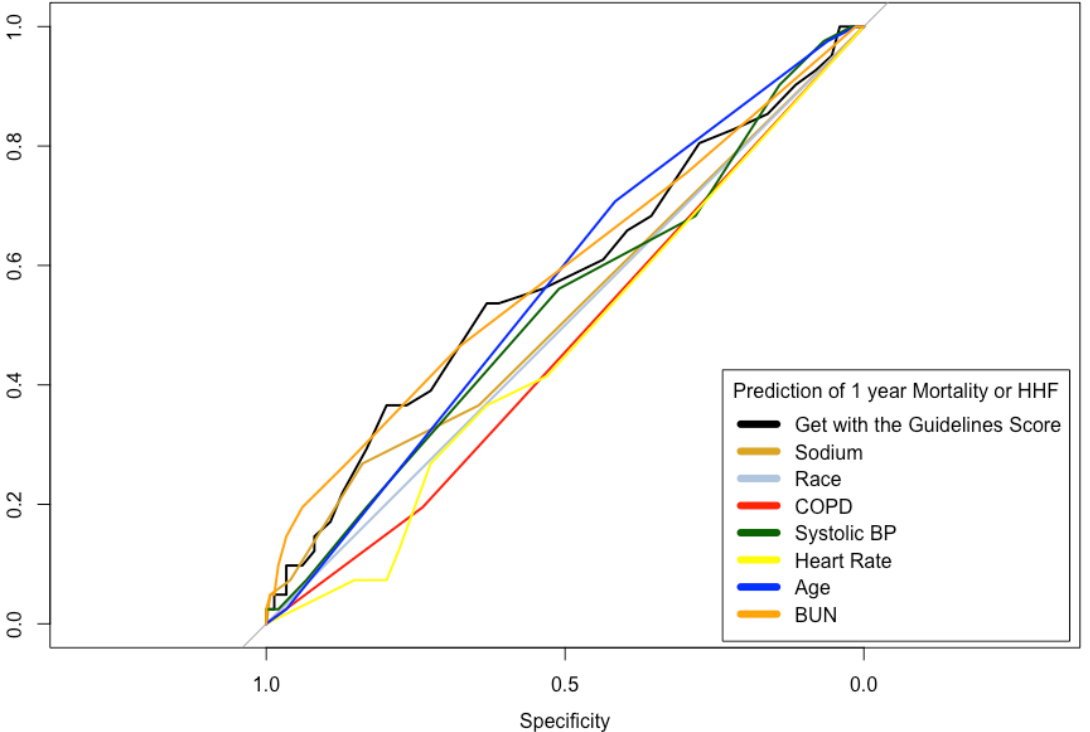
Figure 2. Prediction of composite endpoint (mortality + HHF). ROC analysis for prediction of composite endpoint of mortality and hospitalization for heart failure (AUC 0.57) with GWTG risk score and its predictor variables.